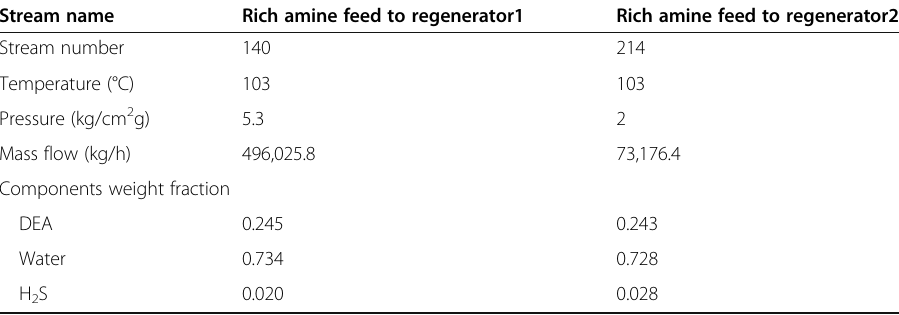
Table 2 Sour water feed characteristics to regenerator1 and regenerator2